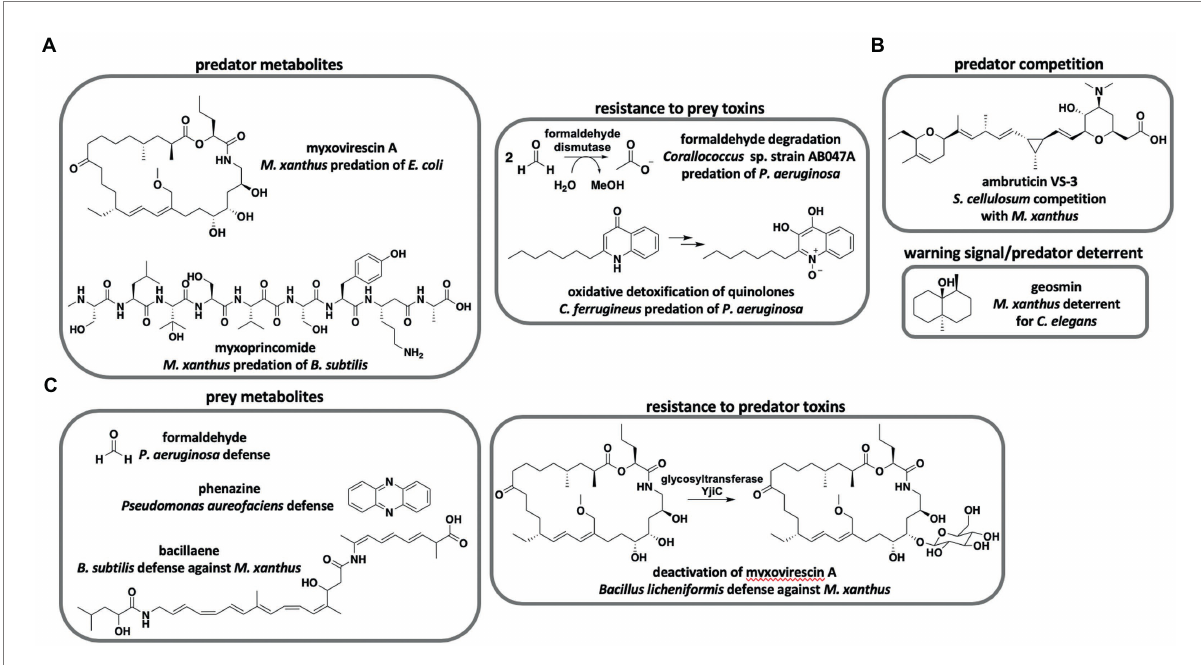
FIGURE 1 Roles of specialized metabolites in myxobacterial predator–prey interactions. (A) Metabolites and metabolic transformations that benefit predation of prey (Xiao et al., 2011; Muller et al., 2016; Sutton et al., 2019; Akbar et al., 2022). (B) Myxobacterial metabolites not directly involved in predation of prey (Marcos-Torres et al., 2020; Zaroubi et al., 2022). (C) Prey metabolites and metabolic transformations that inhibit myxobacterial predation (Bull et al., 2002; Muller et al., 2014; Sutton et al., 2019; Wang et al.,